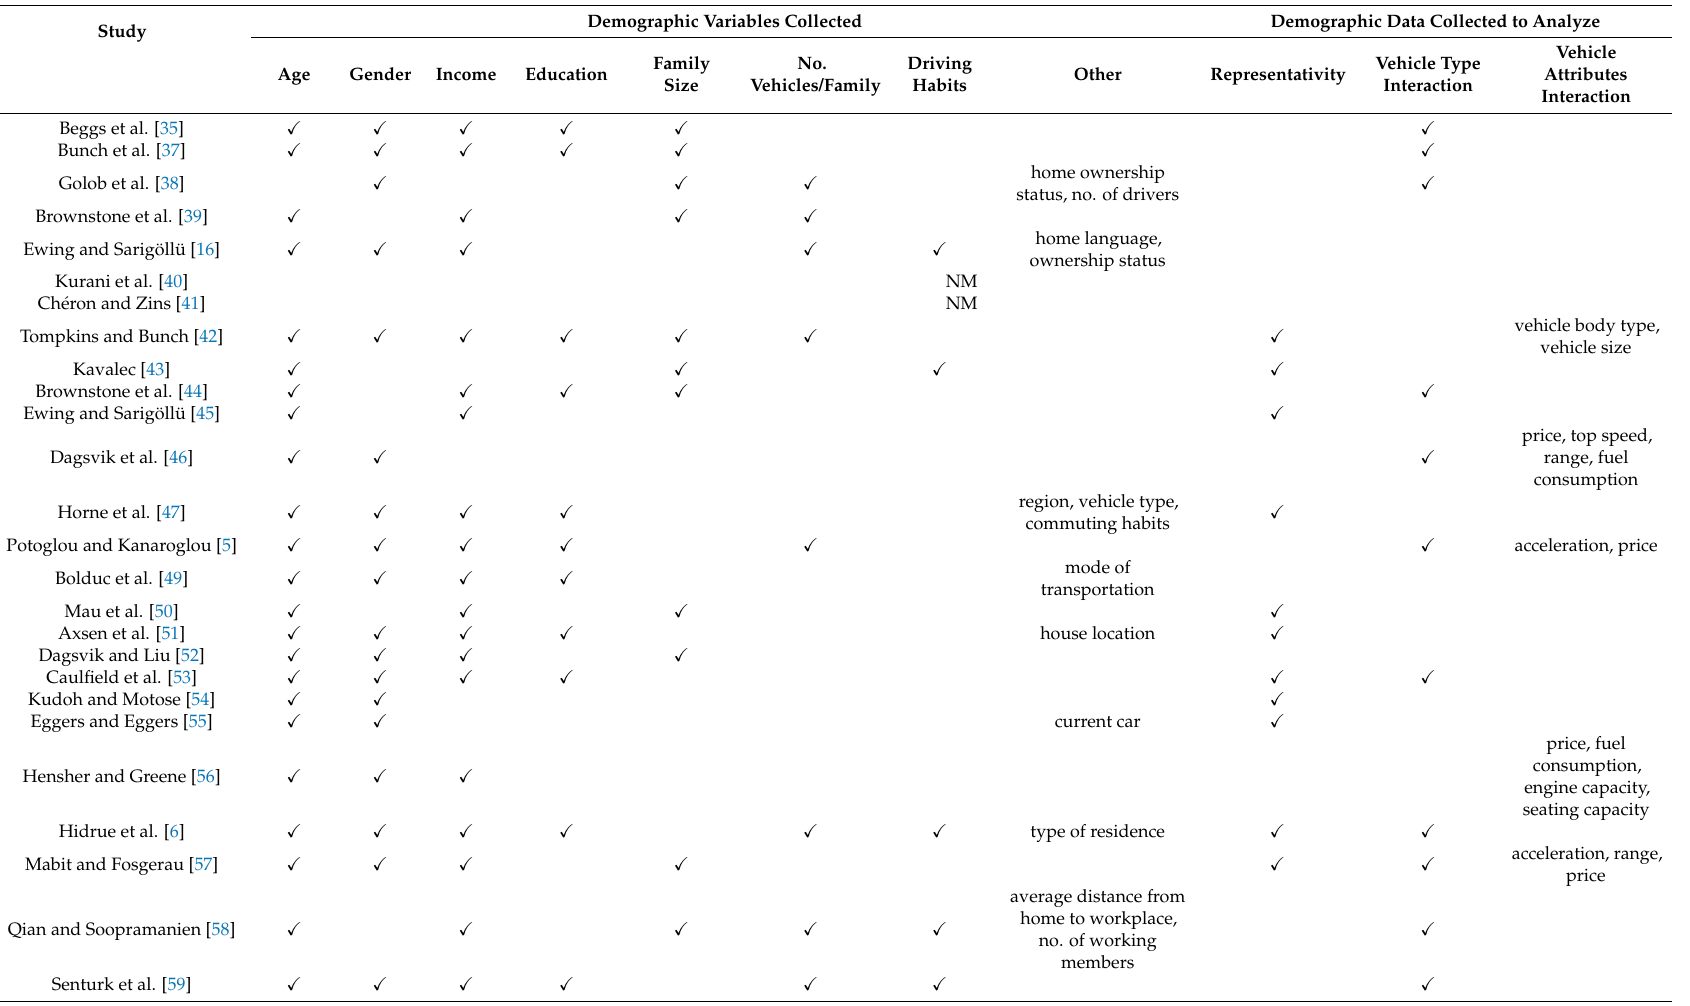
Table 2. Demographic characteristics analyzed in consumer preference studies (NM: Not Mentioned). Study Age Gender Income Education